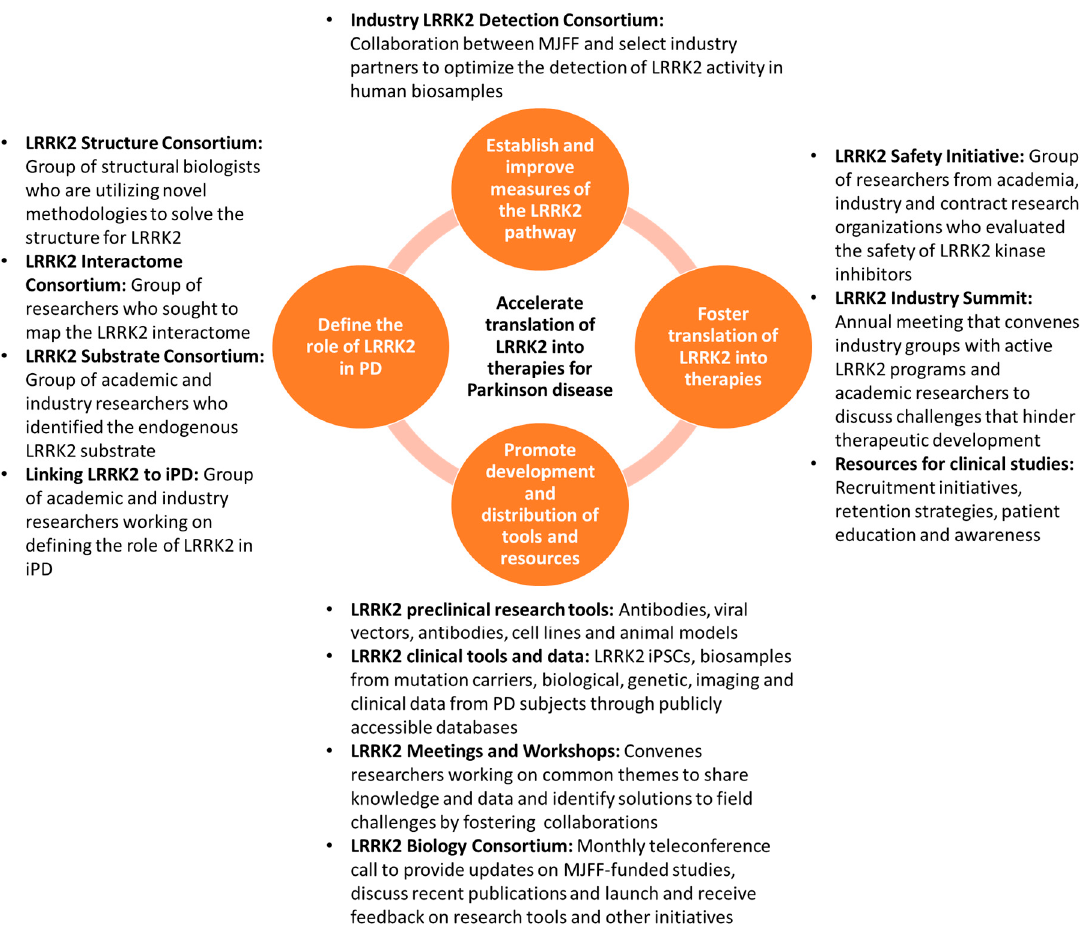
Figure 1. The Michael J. Fox Foundation for Parkinson’s Research (MJFF) applies a “Consortium” approach to tackle key challenges that hinder LRRK2 therapeutic development.